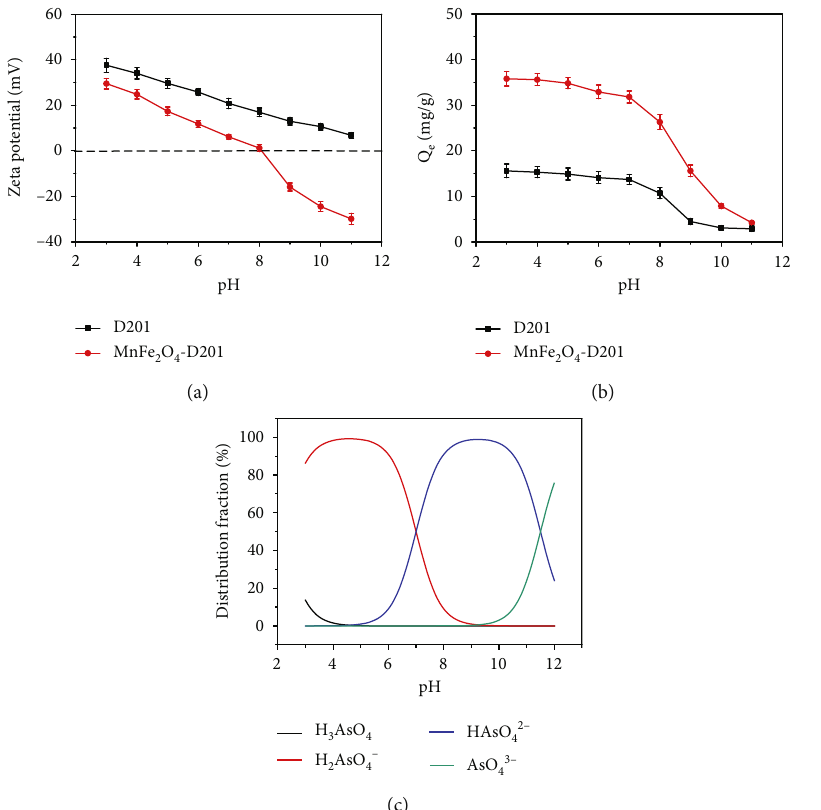
Figure 4: Zeta of D201 and MnFe Fraction of As(V) species at di ff erent pH (c) (the uniform experimental condition: 100 mL of 30 mg/L As(V) with 50mg D201 or MnFe D201, 150rpm, 25 ° C, and 360